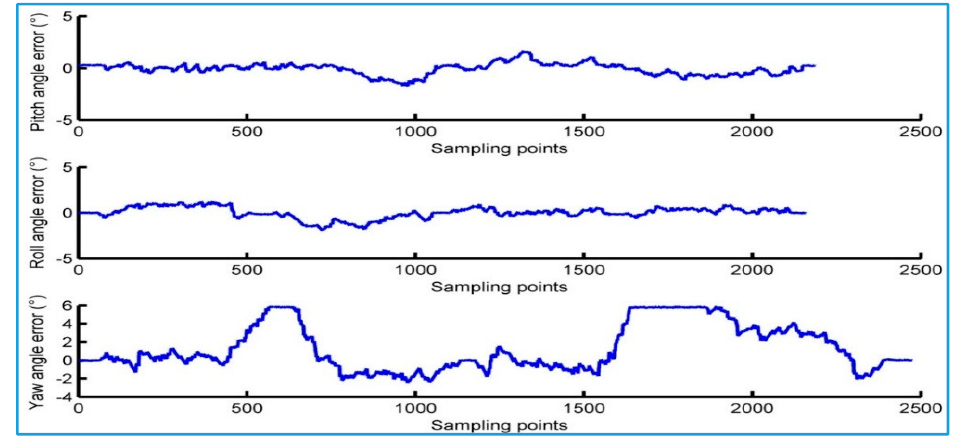
Figure 13. Error of AHRS in dynamic test.